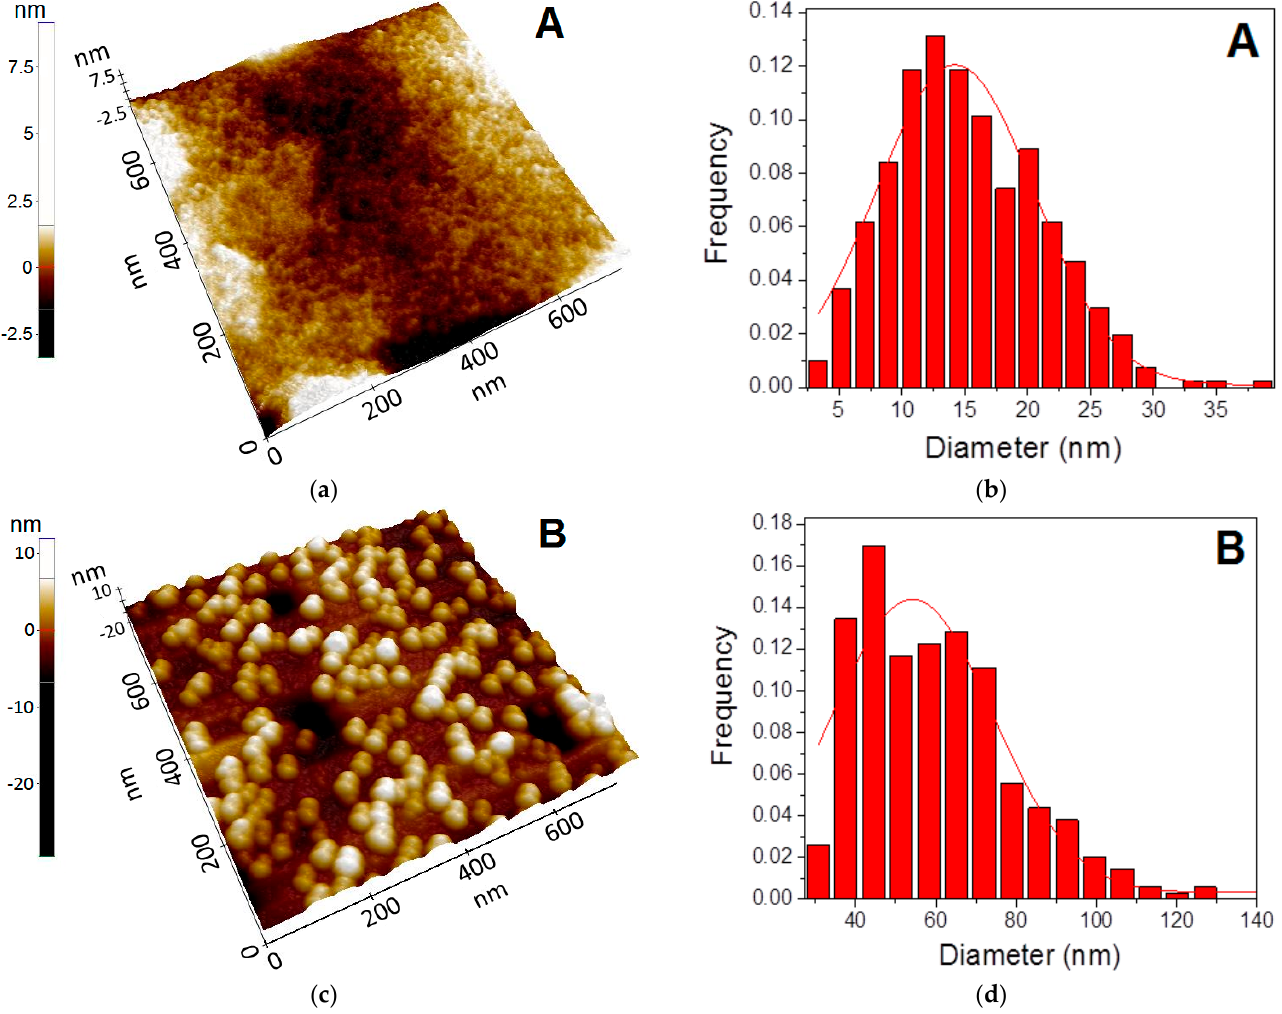
Figure 5. ( a ) 3D AFM images of the hybrid films formed by deposition of silica material. ( b ) Diameter histograms of the superficial particles formed on the surface of silica film ( c ) 3D AFM images of silver-based silica material on glass substrates, registered at the scale of 0.75 μ m × 0.75 μ m. ( d ) Diameter histograms of the superficial particles formed on the surface of silver-based silica film.